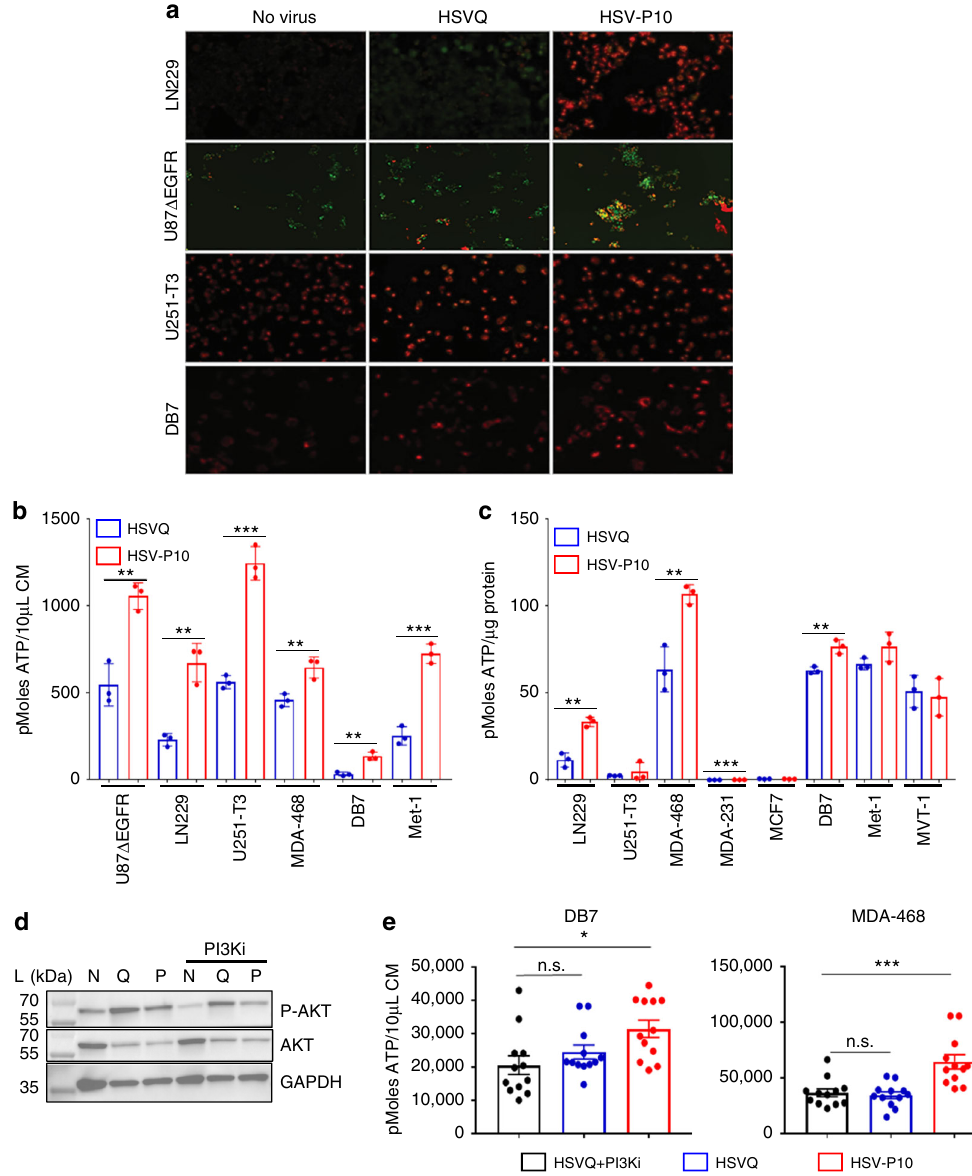
Fig. 3 Effects of PTEN α on HSV-P10 infected cells. a Increased mitochondrial membrane potential in HSV-P10 infected cells 6 hpi. Seeded cells were infected with either HSVQ or HSV-P10 at MOI = 0.5 for 6 h, and mitochondrial membrane potential indicated by JC-1 red fl uorescence was imaged using fl uorescence microscopy. Scale bar = 100 µ m. b ATP release from infected cells 24 hpi. Data shown are mean ATP concentration in conditioned media from infected cells 24 hpi ± S.D. Statistical analysis performed with a 2-tailed Student ’ s T -test. ( n = 3/group, ** p < 0.01, *** p < 0.001). c ATP measured